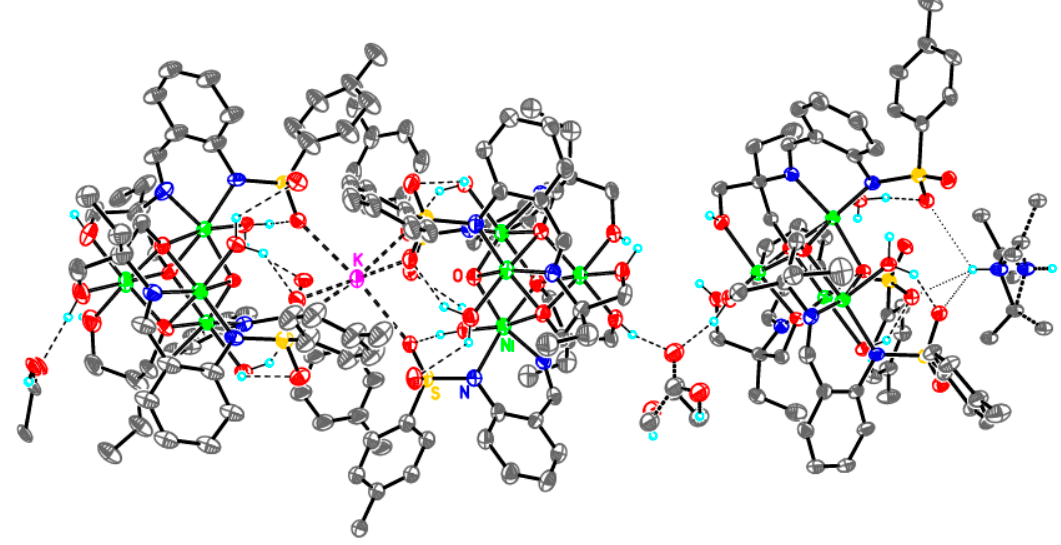
Figure 8. Molecular structure of 3-Ni . Displacement ellipsoids are shown at the 50% probability